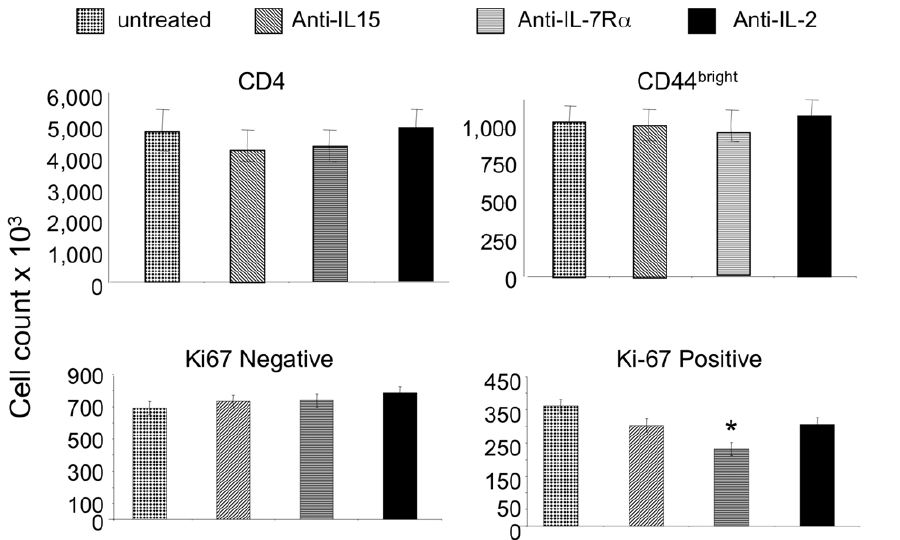
Figure 4. Effect of anti–IL-7R a , anti–IL-15, and anti–IL-2 on in situ MP proliferation. Normal B6 mice were either untreated or received two doses of 0.5 mg of anti–IL-15, anti–IL-7R a , or anti–IL-2 antibody spaced 3 d apart. Mice were humanely killed on day 7 and lymph node cell suspensions were stained with anti-CD4, anti-CD44, and anti–Ki-67. * p , 0.05.